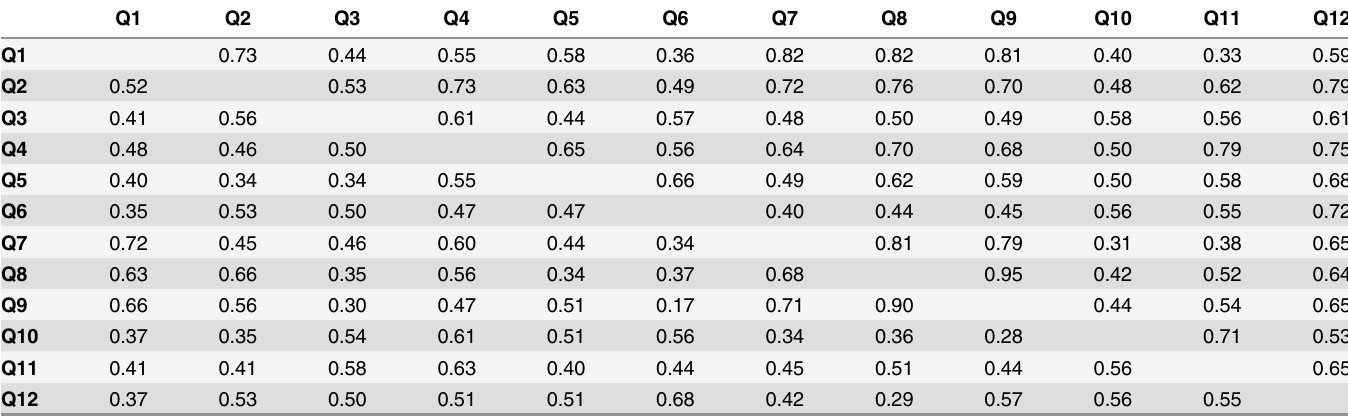
Table 3. WHODAS 2.0 Correlation Matrix.